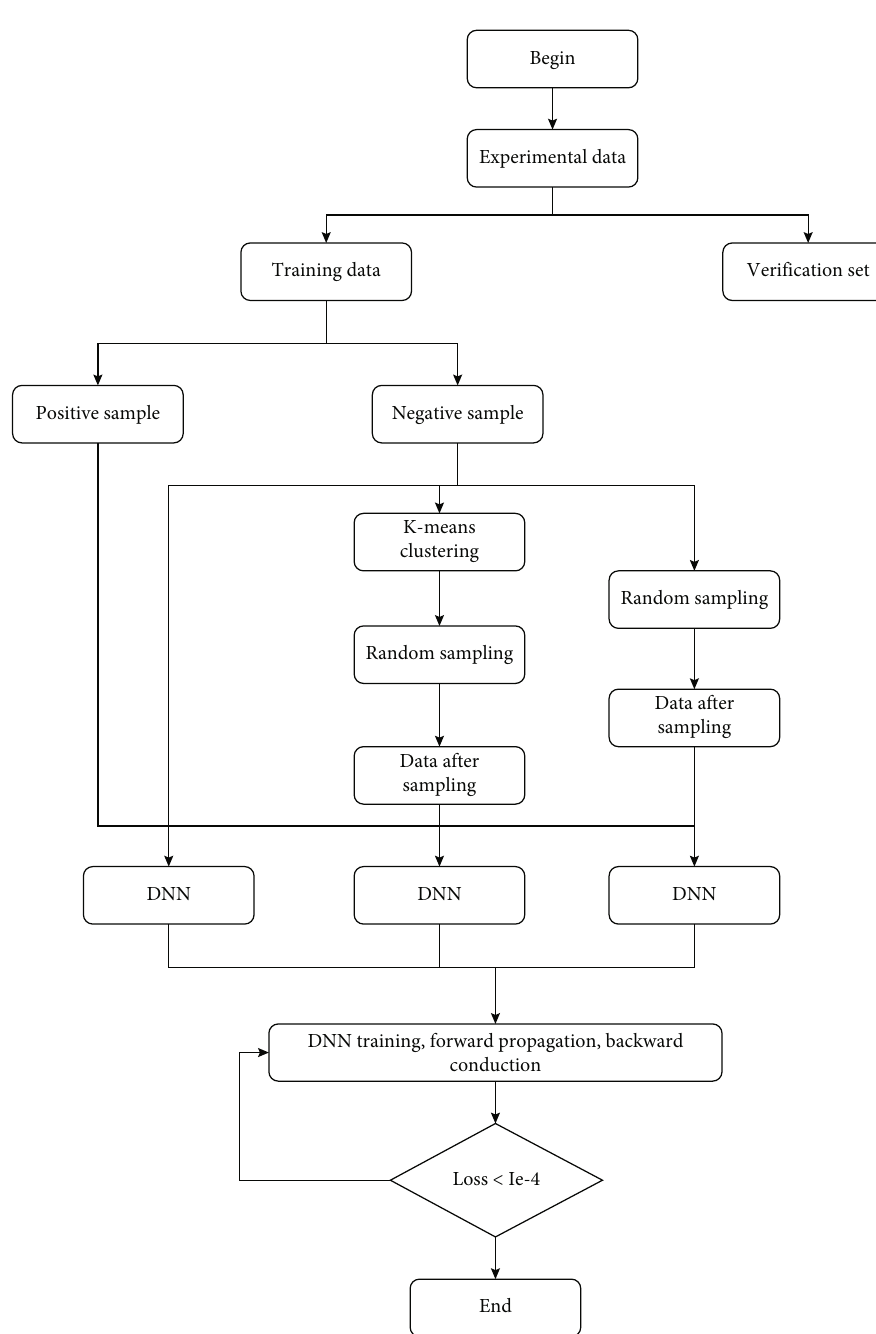
Figure 3: Flow chart of deep learning model